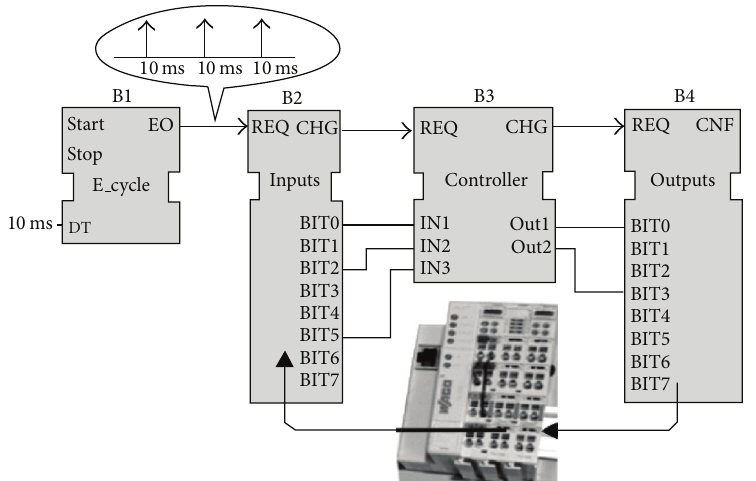
Figure 7: Function block application structure with periodic sampling of inputs